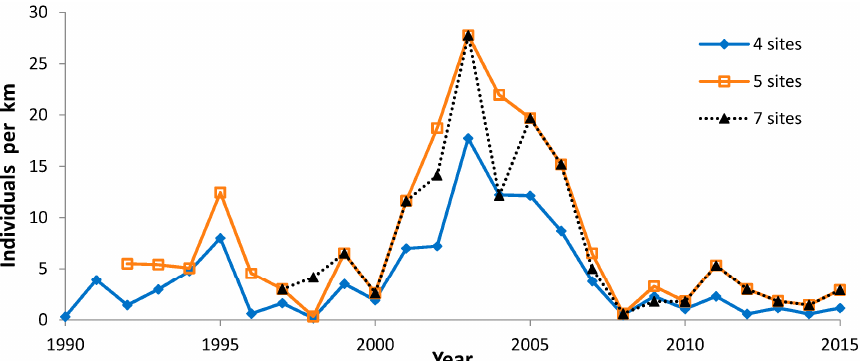
Figure 10. Median regal fritillary individuals per km on peak survey per year at sites surveyed each year: four sites surveyed 1990–2015 (Muralt Bluff, Oliver, Thomson original, Thousand’s II), five sites